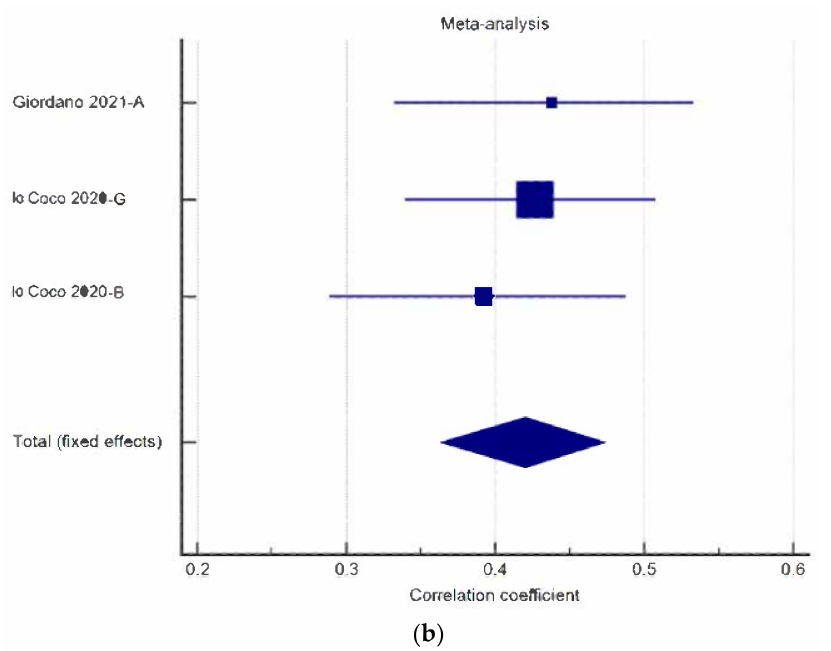
Figure 5. ( a ) Meta-analysis on DERS-SF—SPAI subgroup [49,50]; ( b ) forest plot showing the rela- tionship between emotional dysregulation and PSU in studies using DERS-SF and SPAI scales after removing the 2 parents’ group [49,50].